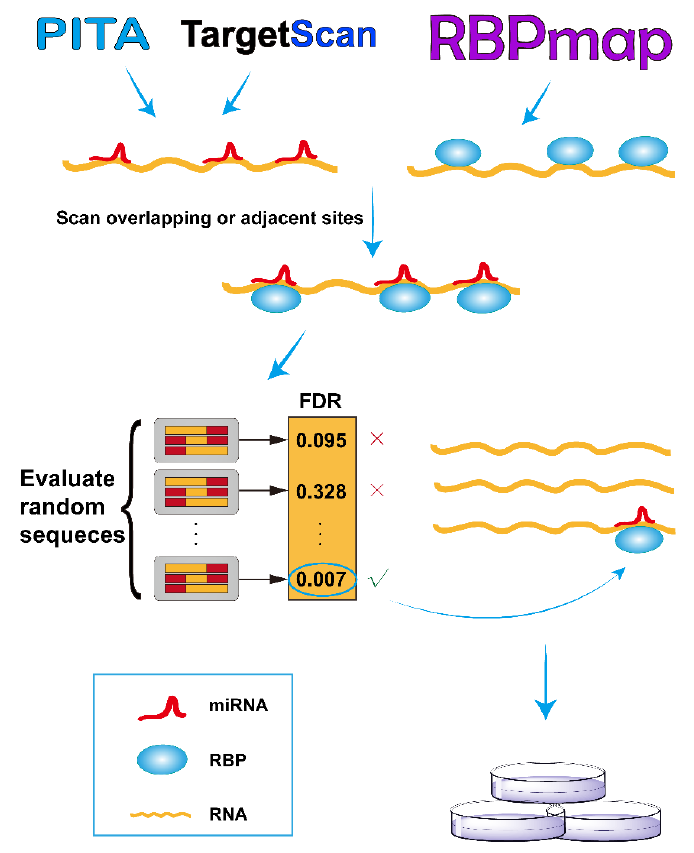
Figure 1. Overview of RBPvsMIR analytical scheme. In the scanning stage, RBPvsMIR initially uses PITA/TargetScan and RBPmap algorithms to respectively search for microRNA (miRNA) and ribosome binding pairs (RBP). Then, during evaluating stage, RBPvsMIR reports the miRNA and RBP pairs with significantly enriched overlapping or very close sites based on a permutation test. Finally, candidate miRNA and RBP pairs are verified by wet experiments. FDR: false discovery